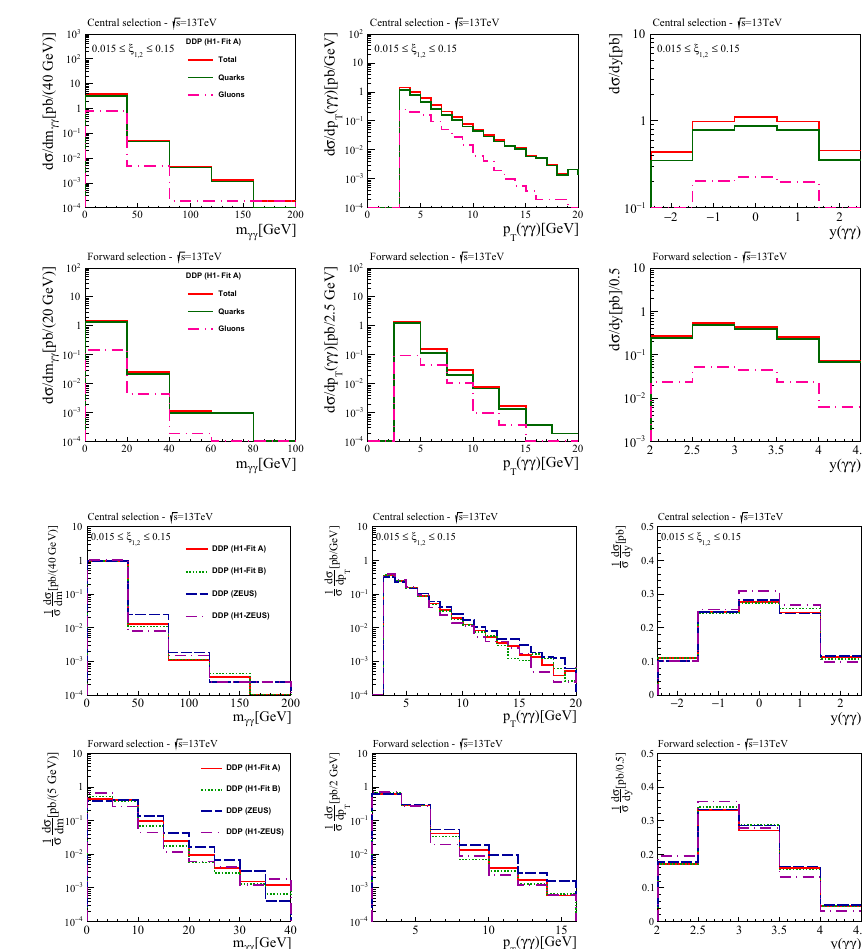
Fig. 3 Comparison between the predictions associated to the q ¯ q → γγ (denoted quarks) and gg → γγ (denoted gluons) subprocesses for the invariant mass m γγ , transverse momentum p T (γγ) and rapidity y (γγ) distributions of the diphoton system produced in pp collisions at the LHC. Results for a central (forward) detector are presented in the upper (lower) panels